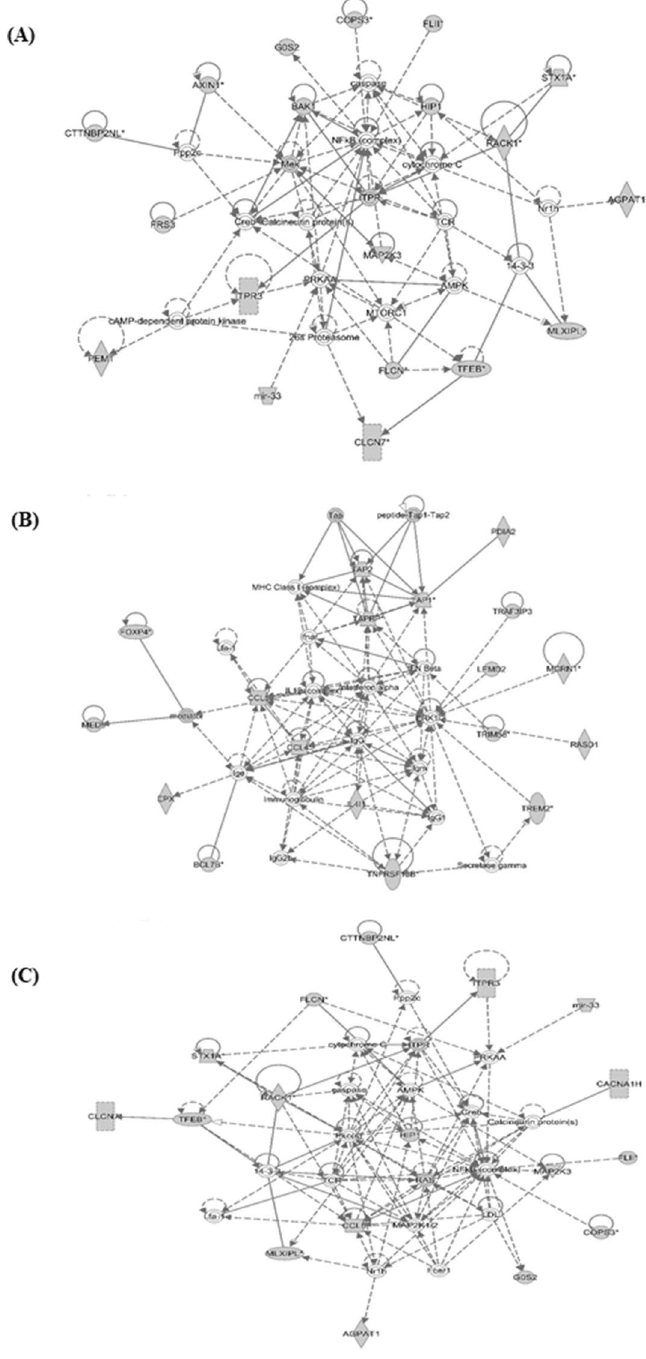
Figure 6. Network analysis using the IPA software (https ://digit alins ights .qiage n.com/produ cts-overv iew/ disco very-insig hts-portf olio/analy sis-and-visua lizat ion/qiage n-ipa/). Three networks, related to immunological disease ( A ), cell death and survival ( B ), and molecular transport and protein trafficking ( C ) are shown that illustrate the molecular interactions between the products of candidate genes selected from QTL regions for Campylobacter colonisation resistance in commercial chickens. Arrows with solid lines represent direct interactions and arrows with broken lines represent indirect interactions. Genes with white labels are those added to the IPA analysis because of their interaction with the target gene